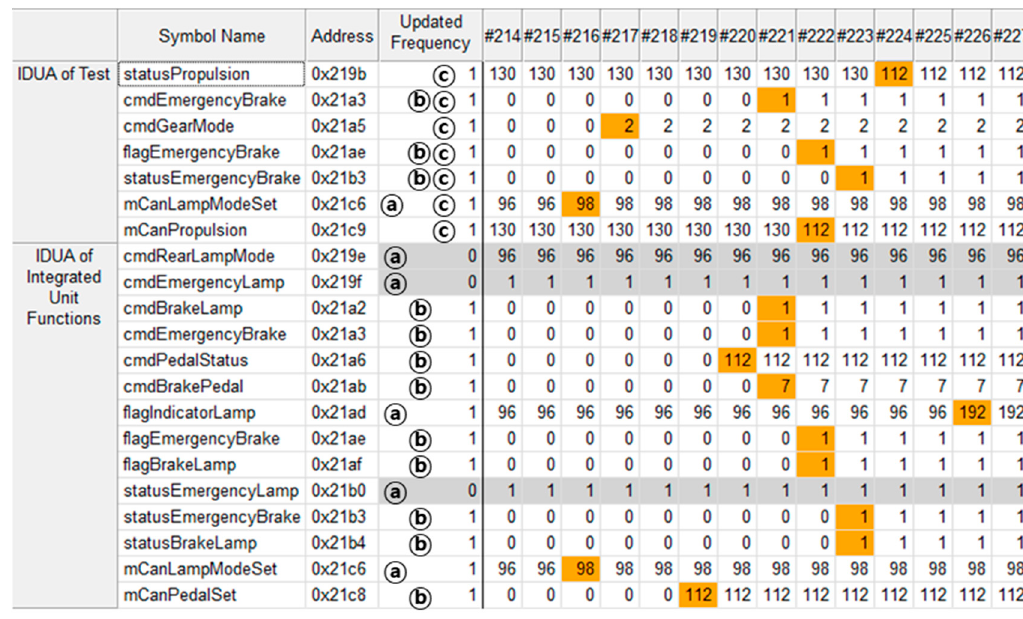
Figure 12. Fault Candidates of the Fault Index #12.